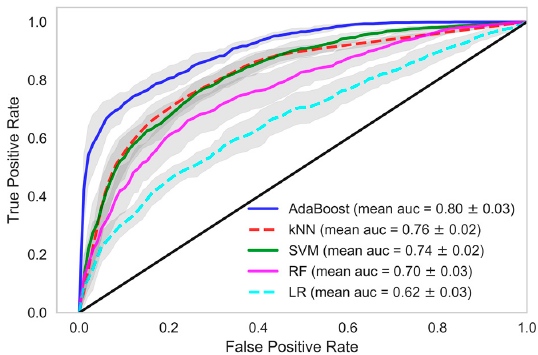
Figure 3. Receiver Operating Characteristics plot showing mean area under curve of all the classifiers of Model-2 when all HD sessions were considered.